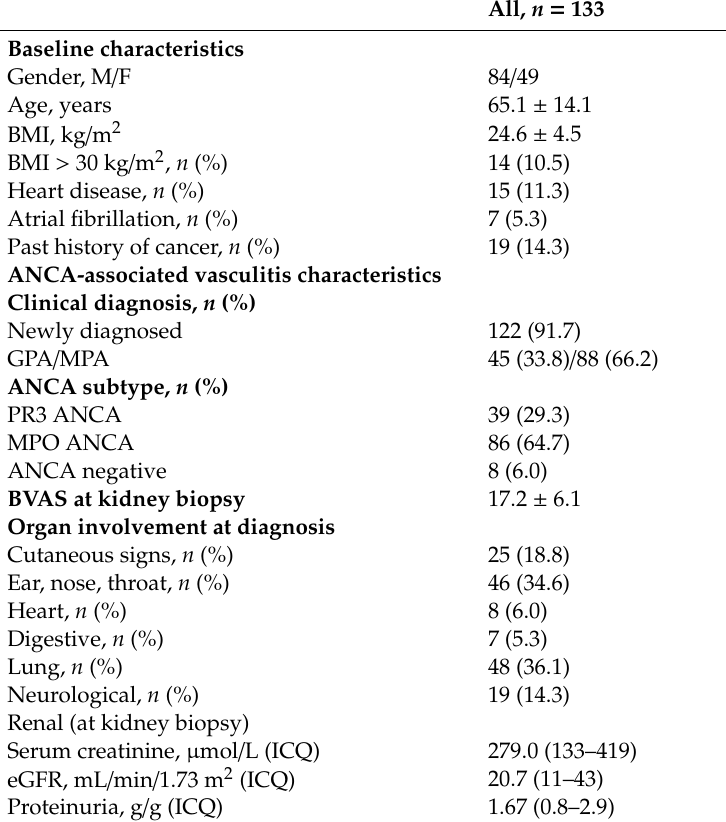
Table 1. Baseline characteristics of the population and outcome.